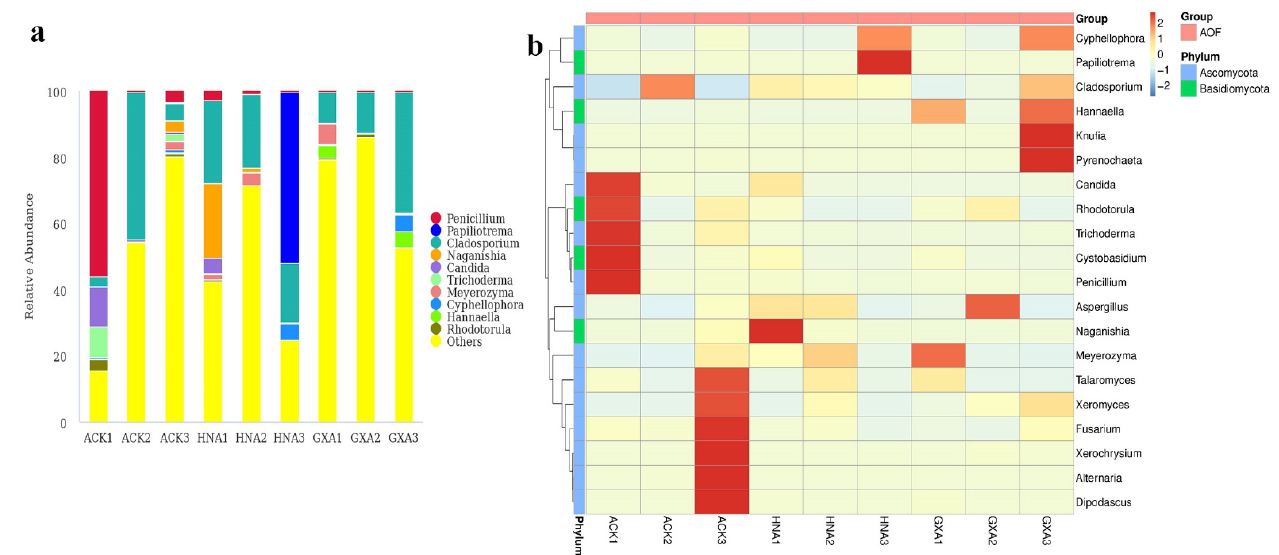
Figure 5. Composition analyses of the fungal microbiomes in the AOF samples. ( a ) Fungal composition in AOF samples at genus level; ( b ) Heatmap of the top 20 genera in AOF samples. It is worth noting that a potential toxigenic fungus, namely, Trichoderma atroviride , was detected in all samples. Furthermore, another potential toxigenic fungus ( Fusarium equiseti ) was detected in four non-moldy samples (MCK1, MCK2, ACK1, and ACK3). The species and relative abundance of harmful fungi in each sample are shown in Supplementary Table